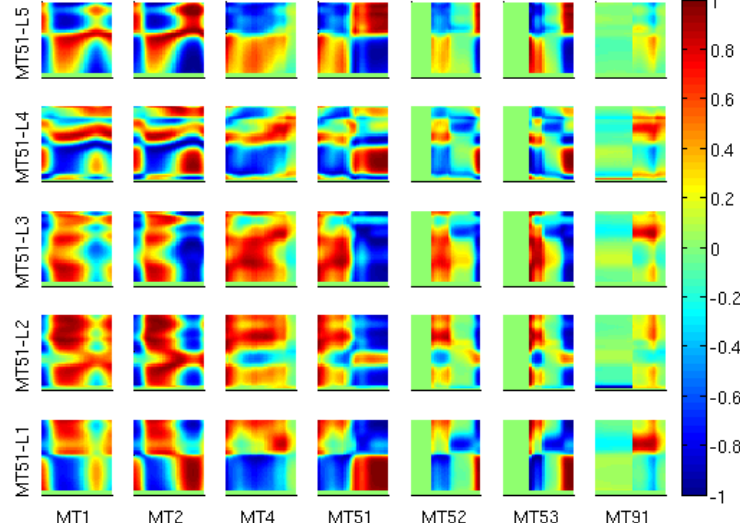
Figure 4. Correlation matrices between angle-integrated cross sections and Legendre coefficients of first-level-inelastic